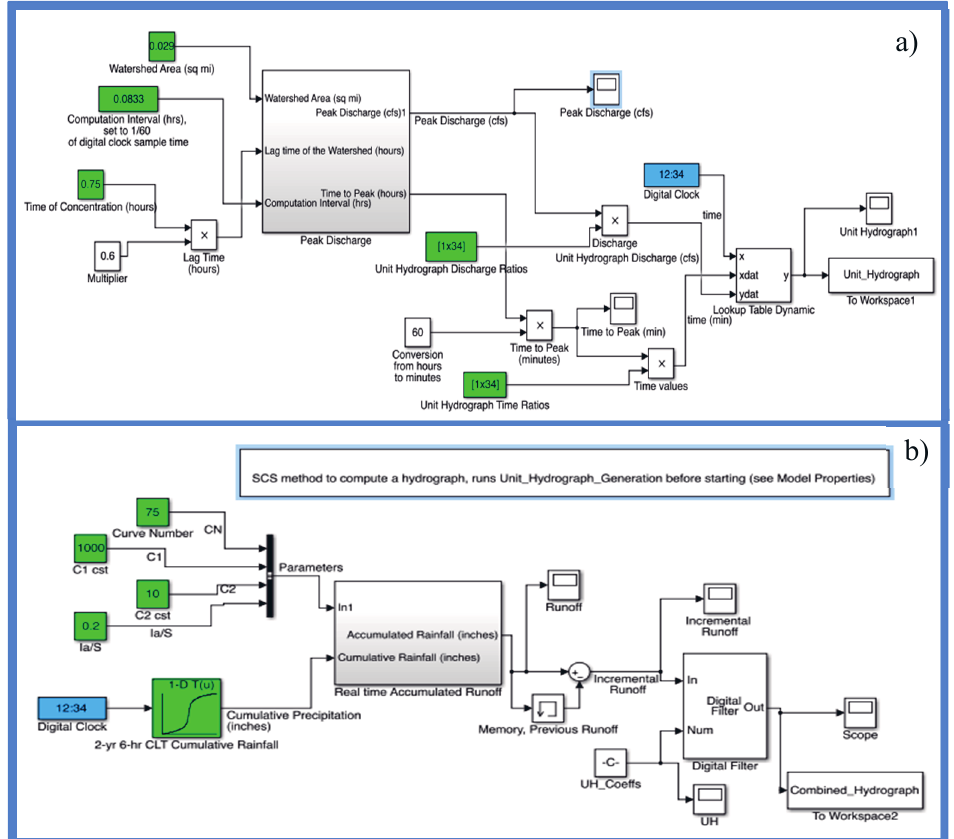
Figure 5. Soil Conservation Service (SCS) Method Runoff Calculation Model Using Simulink. Unit hydrograph generation model ( a ) is run first with output passed to workspace. Runoff calculation ( b ) reads unit hydrograph from workspace and convolutes signal with incremental runoff time